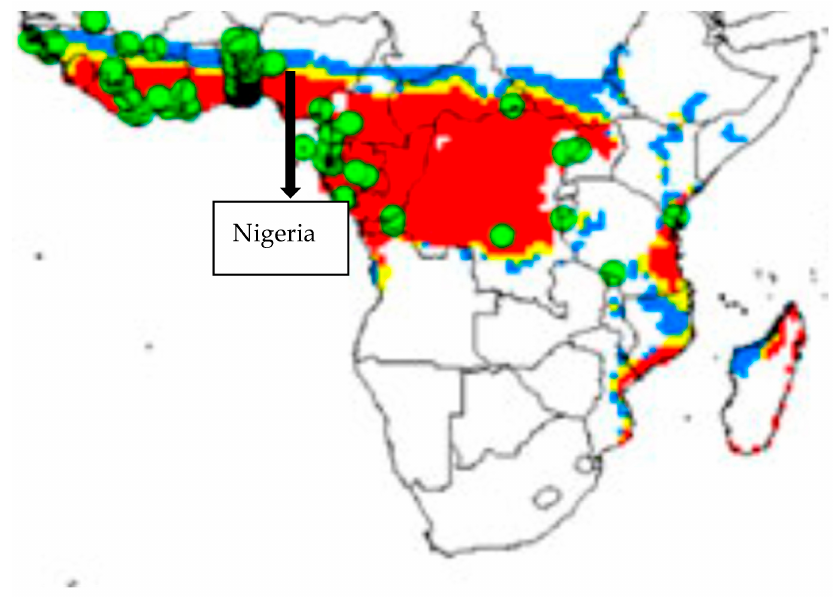
Figure 2 . Suitable climate map for OP growing in Africa adapted from [24] with Nigeria indicated. Highly suitable climate (red), suitable climate (yellow), marginal climate (blue) and unsuitable climate (white) in current time. Green spots are existing OP plantations. The map was divided equally into 16 regions from north to south and west to east to determine the climate suitability of each region. The unsuitable climate region in current time was not included in all determinations.